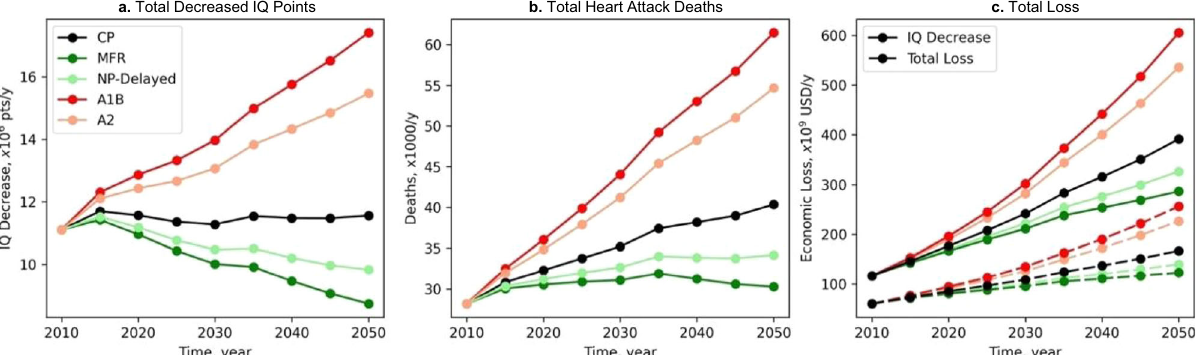
Fig. 4 Trajectories of global annual health effects associated with different future emission scenarios. ( a ) Total intelligence quotient (IQ) decrements of newborns; ( b ) Total heart attack deaths; ( c ) Economic valuation of health effects: total valuation (solid lines) and from IQ decrements (dashed lines). Five scenarios are included: A1B (business as usual), A2 (divided world scenario), CP (current policy), NP-Delayed (new policy delayed), and MFR (maximum feasible reduction).